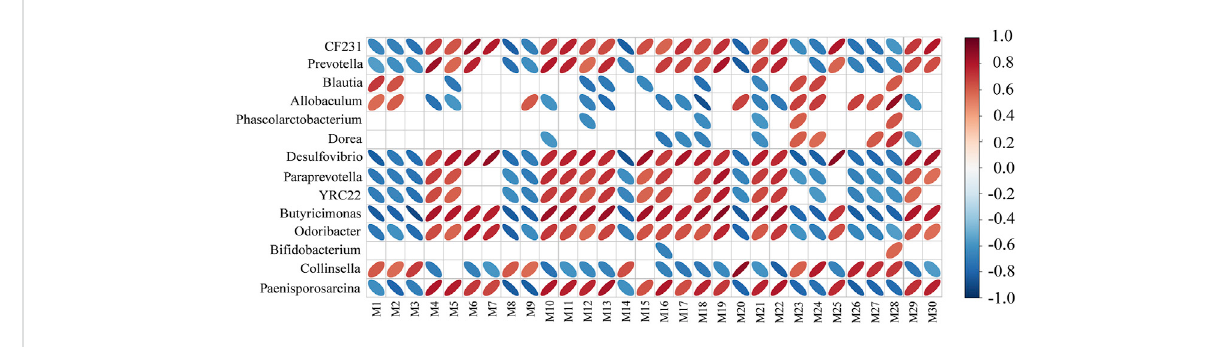
FIGURE 9 Corrections between the top 30 metabolites ranked by VIP value and intestinal fl ora. The red ellipse represents a positive correlation, and the blue ellipse represents a negative correlation. The greater the absolute value of the correlation, the thinner the ellipse. A blank grid represents a signi fi cant p value greater than 0.05.